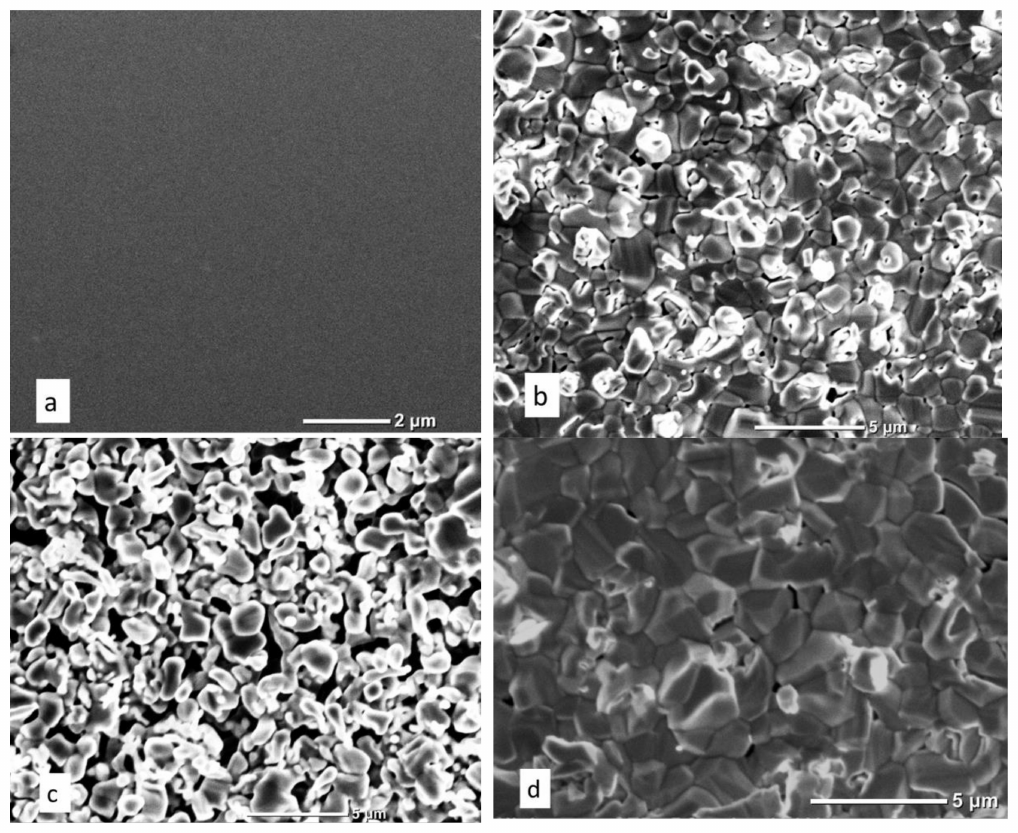
Figure 4. SEM images of sample surface: titanium film on sapphire ( a ); type I ( b ); type II ( c ); type III ( d